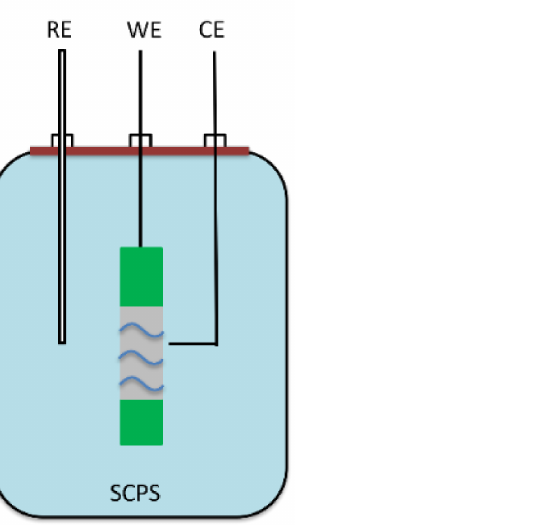
Figure 1. Configuration of a typical three-cell exposure test for